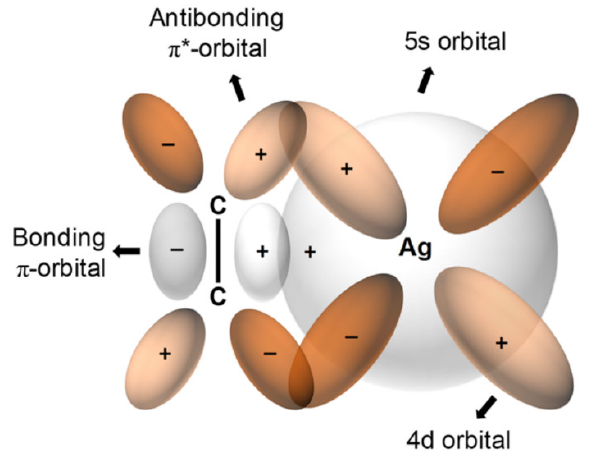
Figure 1. Coordination between a transition metal and olefin. Adapted from Ref. [25] with permission. Copyright (2018) American Chemical Society.